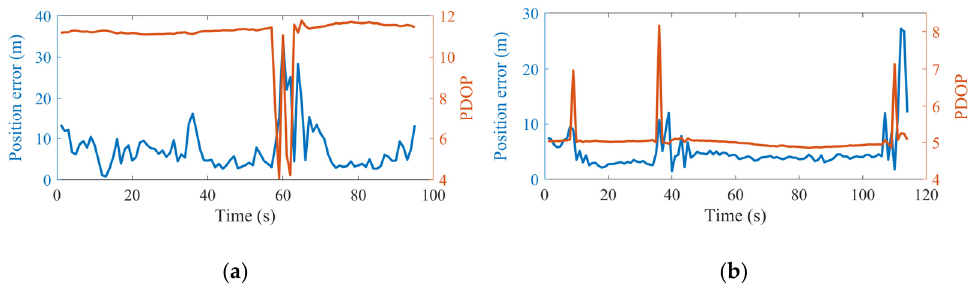
Figure 23. Position error and PDOP when 3 satellites are visible. ( a ) Clockwise. ( b ) Counter-clock-